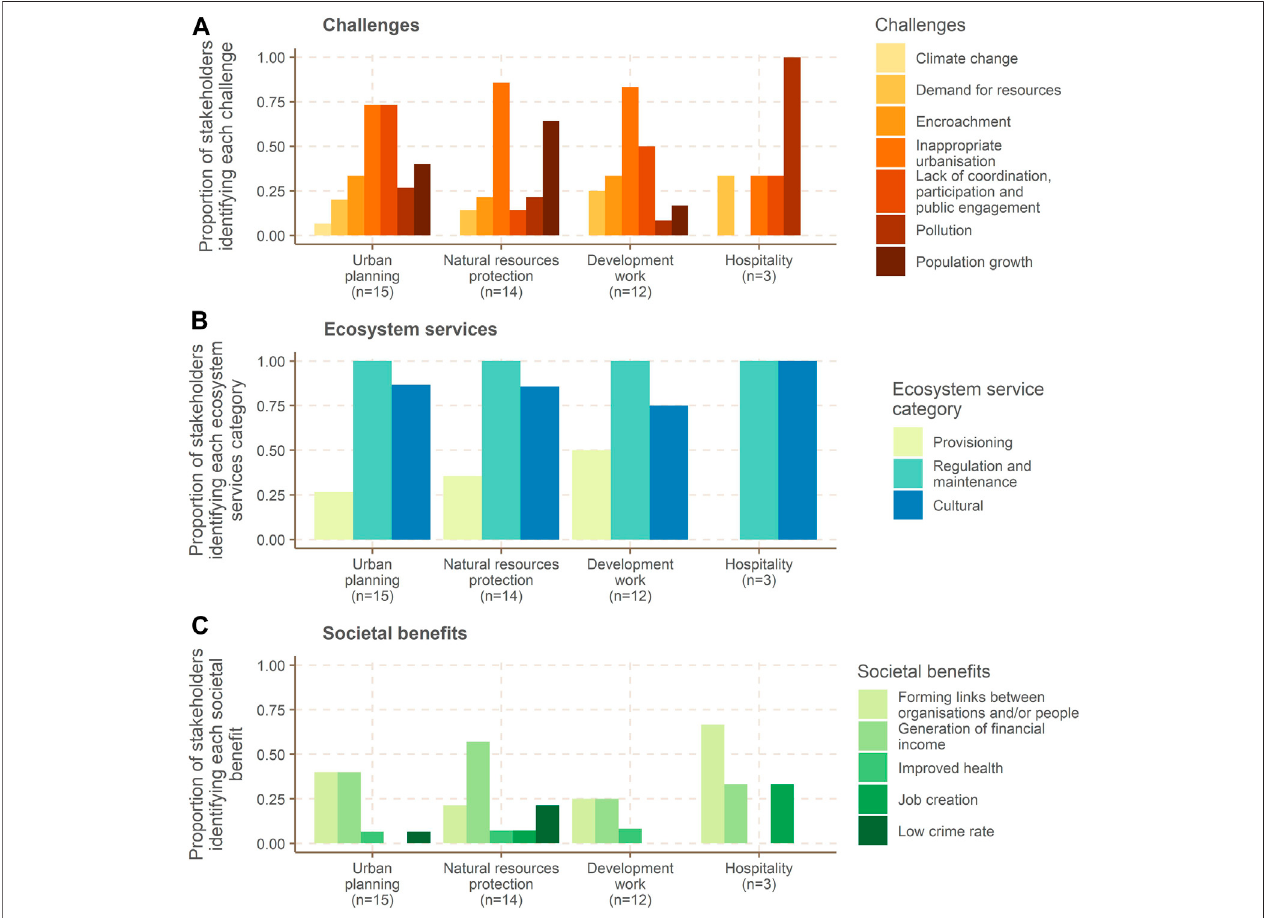
FIGURE 3 | Proportion of stakeholders with each focus identifying (A) challenges threatening appropriate greenspace management, (B) ecosystem services and (C) societal bene fi ts provided by urban greenspaces. Stakeholders could report multiple challenges, ecosystem services and bene fi ts.